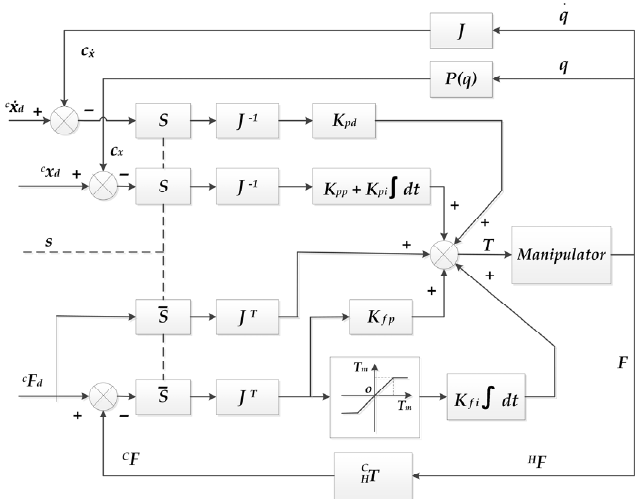
Figure 7. R-C controller structure diagram. (The “ S ” and” (cid:1845)̅ ” are the fitness selection matrices; the “ c x d ” and “ c F d ” are the desired position and force trajectories defined in the cartesian coordinate system; the “ P(q) ” is the kinematic equation of the manipulator; the “ (cid:1846) (cid:3009)(cid:3004) ” is the force transfor- mation matrix; “ q ” is the joint position; “ (cid:1869)(cid:4662) ” is the velocity.)